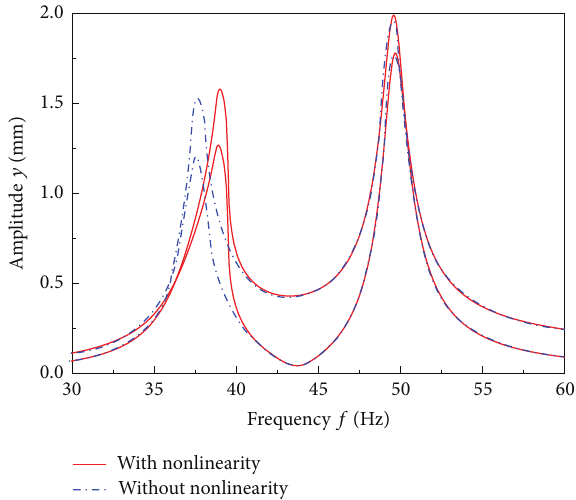
Figure 10: Responses of the rotor-absorber system when ℎ is 5 mm and 𝛿 is 0.1 mm. Aluminum frame